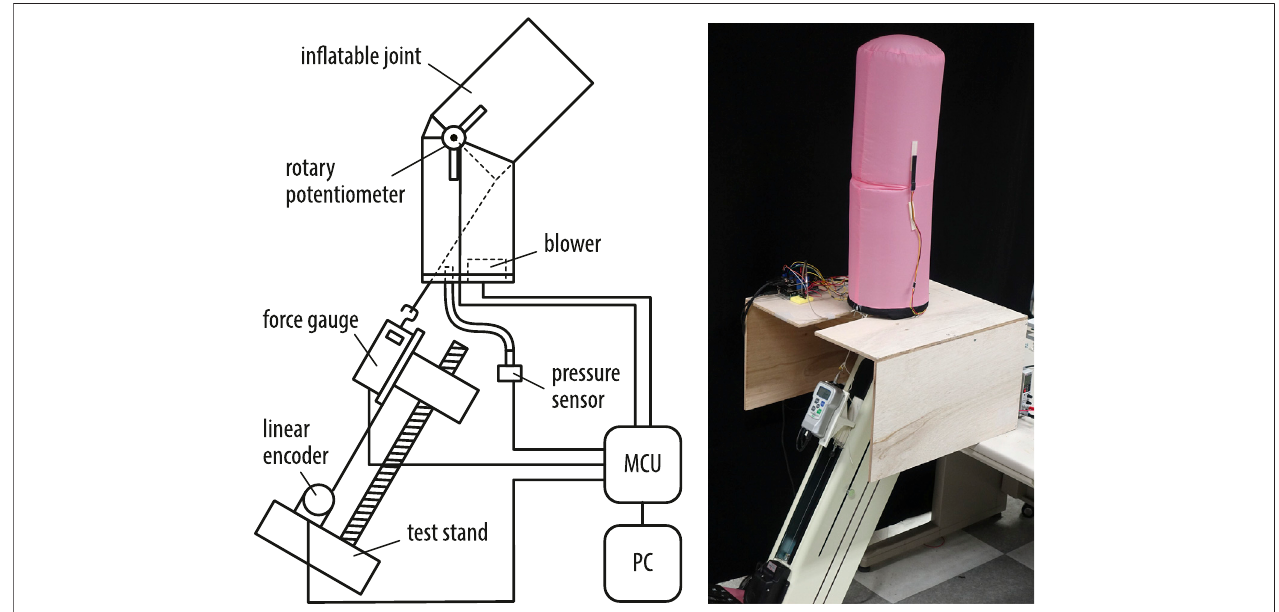
FIGURE 4 | Schematic diagram of the experimental setup and a photo of the measurement.